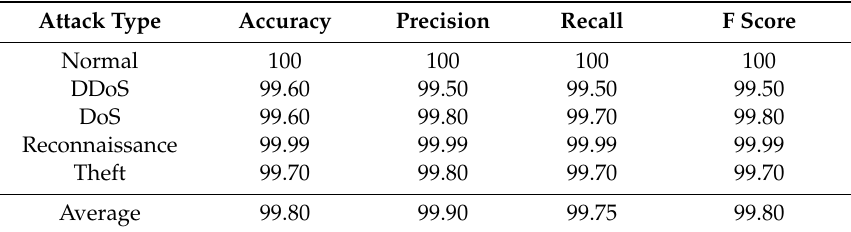
Table 11. Accuracy, Precision, Recall, and F Score for 10-Fold Cross-Validation.